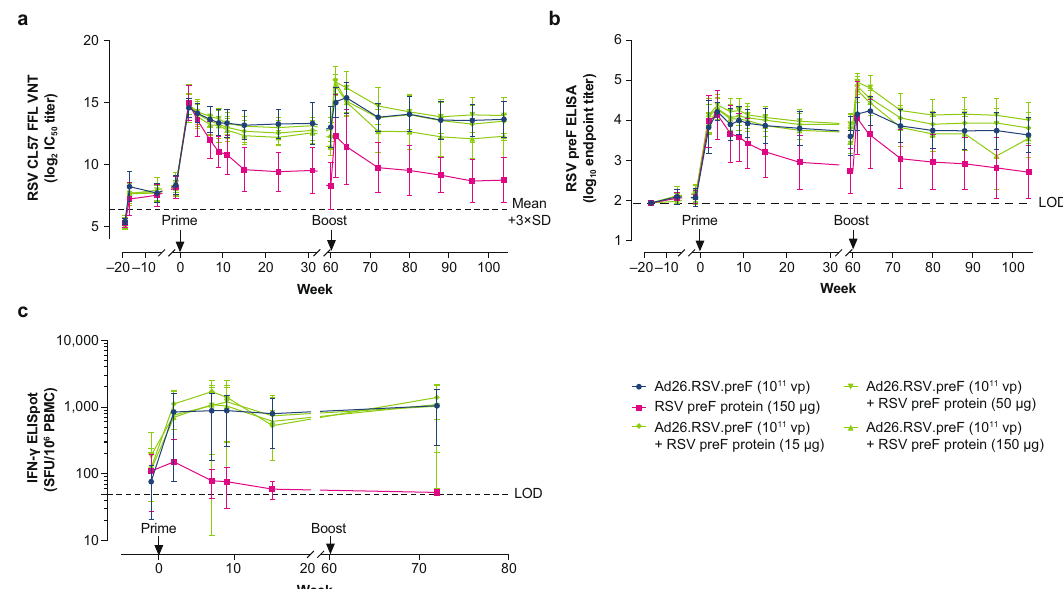
Fig. 5 Humoral and cellular immunogenicity measured in African green monkey serum. Female African green monkeys were pre-exposed i.n. with RSV Memphis 37 (7.5 × 10 5 pfu) at Week – 19 and immunized intramuscularly with Ad26.RSV.preF (1 × 10 11 vp; n = 11); RSV preF protein (150 µg; n = 4); or a combination of Ad26.RSV.preF (1 × 10 11 vp) with RSV preF protein (15, 50, or 150 µg; n = 7 in each group) at Week 0 with homologous boost immunization at Week 60. RSV CL57 VNT, expressed as log 2 IC 50 , were measured in serum samples; dots represent mean VNT per group; error bars indicate SD ( a ). LOD was determined as 3×SD above mean VNTof Week – 19 serum samples and indicated by a dotted line. RSV preF IgG-binding titers, expressed as log 10 endpoint titers, were measured by ELISA in serum samples ( b ). Dots represent mean titers per group; error bars indicate SD. LOD was determined as log 10 of the inverse of the lowest serum dilution. PBMCs were obtained before immunization (but after pre-exposure) and after immunization at Weeks 2, 7, 9, 15, and 72 for measurements of cellular